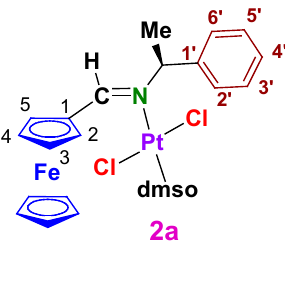
Figure A1. Atom labelling scheme for compound 2a